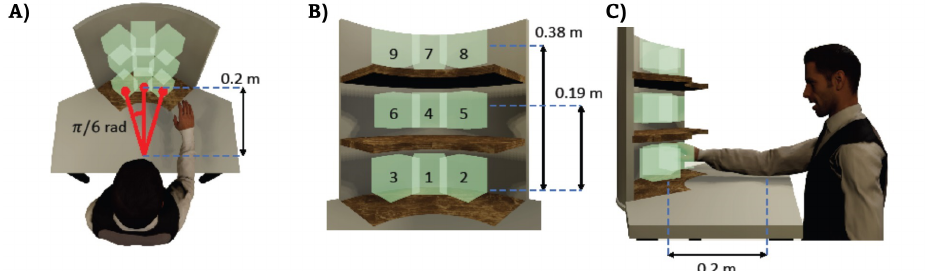
Figure 3. Top, front and lateral view of the shelf unit are shown in ( A – C ), respectively. The positions of the targets to be reached are